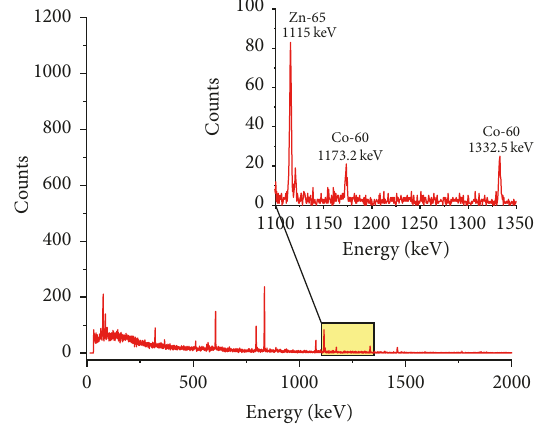
Figure 6: Gamma-ray spectrum of the 𝛾 -MnO 2 nanomaterial before the adsorption of elements in the seawater.